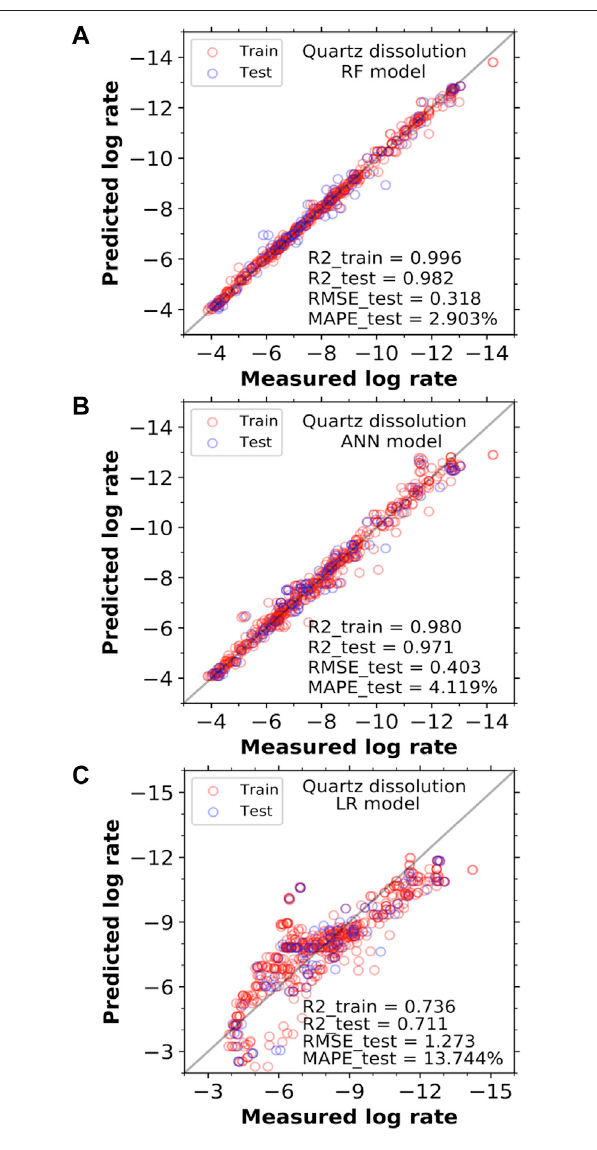
FIGURE 4 | Comparison of the measured quartz dissolution rates in log scale(mole/m 2 /s)withthepredicted valuesfromthe (A) RF, (B) ANN,amd (C) LR models, based on fi ve input features (i.e., temperature, pH T , pressure, and Na + and Al 3+ content). In each case, the error metrics for the training set comprises85%oftheentiredataset(includingboththetrainingandvalidation folds used during the fi ve-fold cross-validation process), while the remaining 15% of the data that have not been exposed during model training is used as the test set. Selected error metrics (i.e., MAPE, R 2 and RMSE) for both the trainingandtestingsetsareshowninthe fi gures.Thesolidgreylinesrepresent the line of equality between the measured and predicted rates.